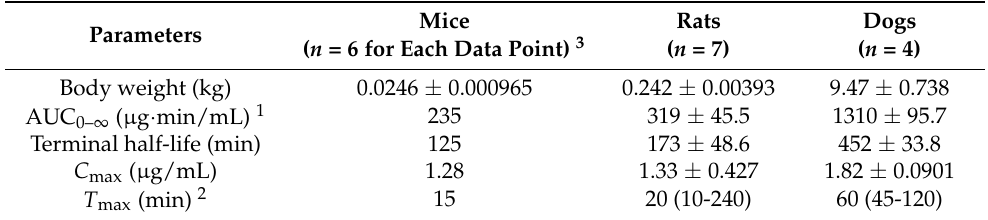
Table 4. Pharmacokinetic parameters for DA-7010 after single oral administration at a dose of 3 mg/kg to mice, rats, and